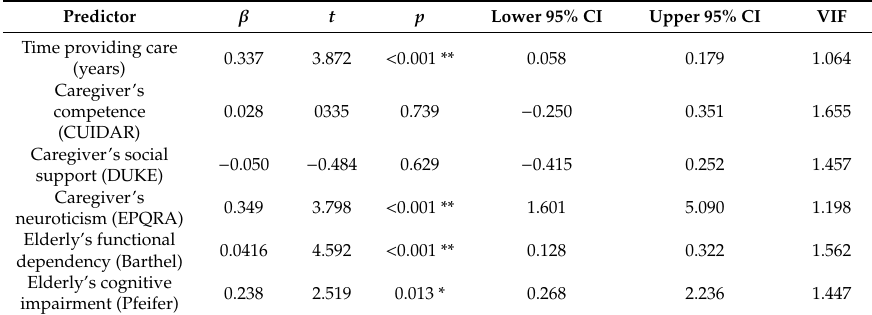
Table 3. Prediction of burden in informal male caregivers.